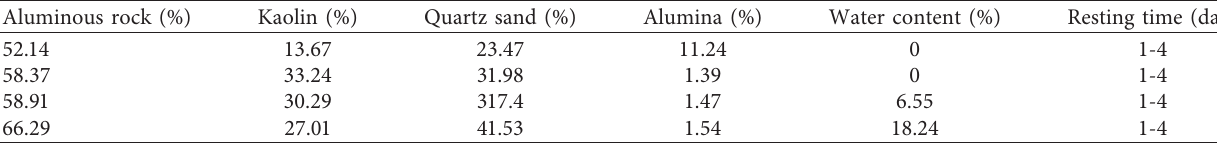
Table 3: Formulation of general alumina ceramics.